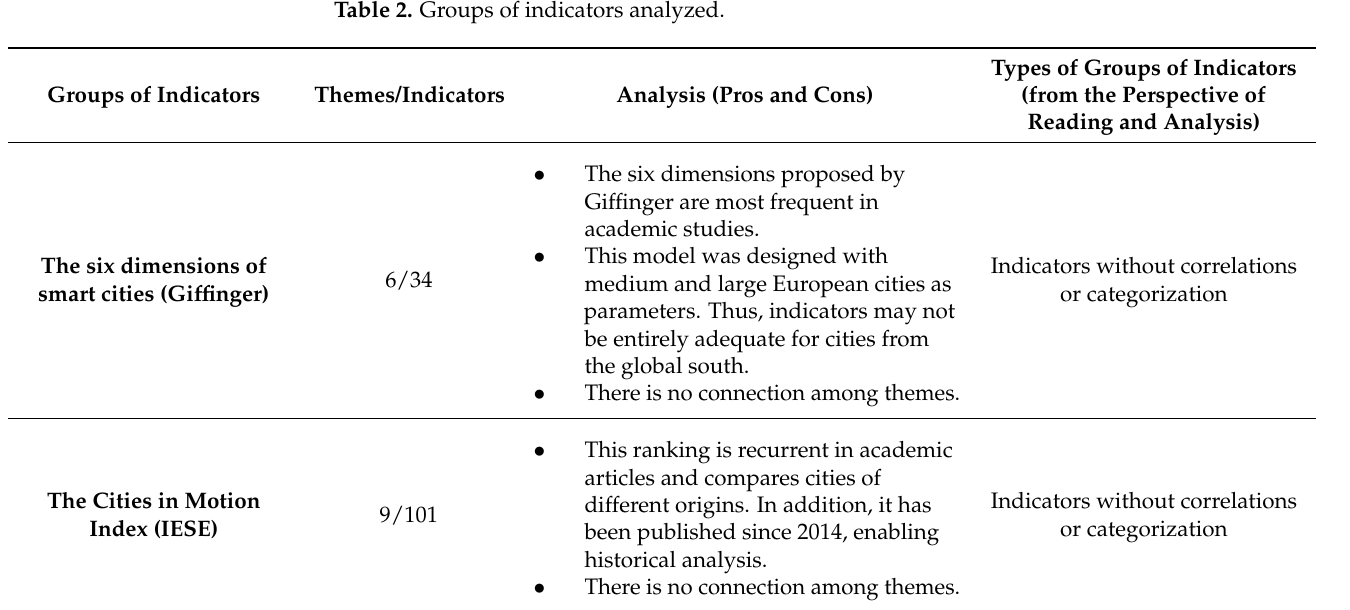
Figure 11. The tree dimensions of the smart sustainable cities maturity model and its categories. Source: [119,124]. Adapted by the author. Table 2. Groups of indicators